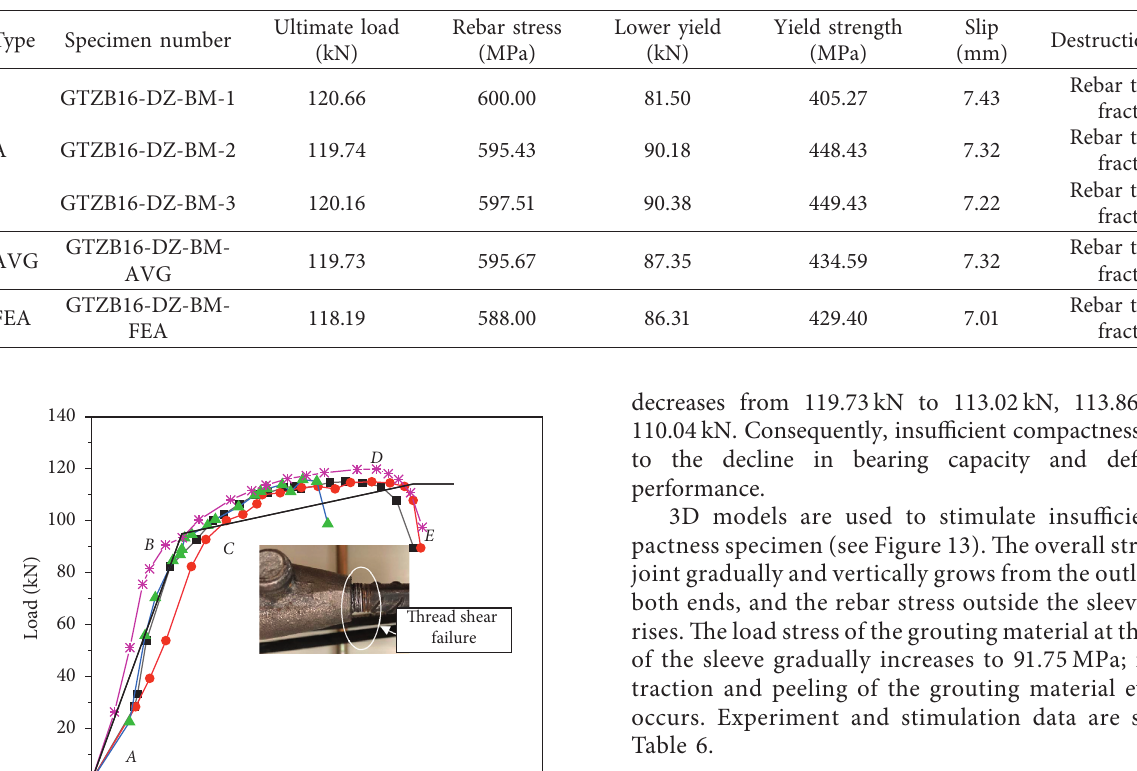
Figure 8: The finite element stimulation stress distribution diagram of the control group (unit: MPa). Table 4: Experiment and stimulation results of the control group.